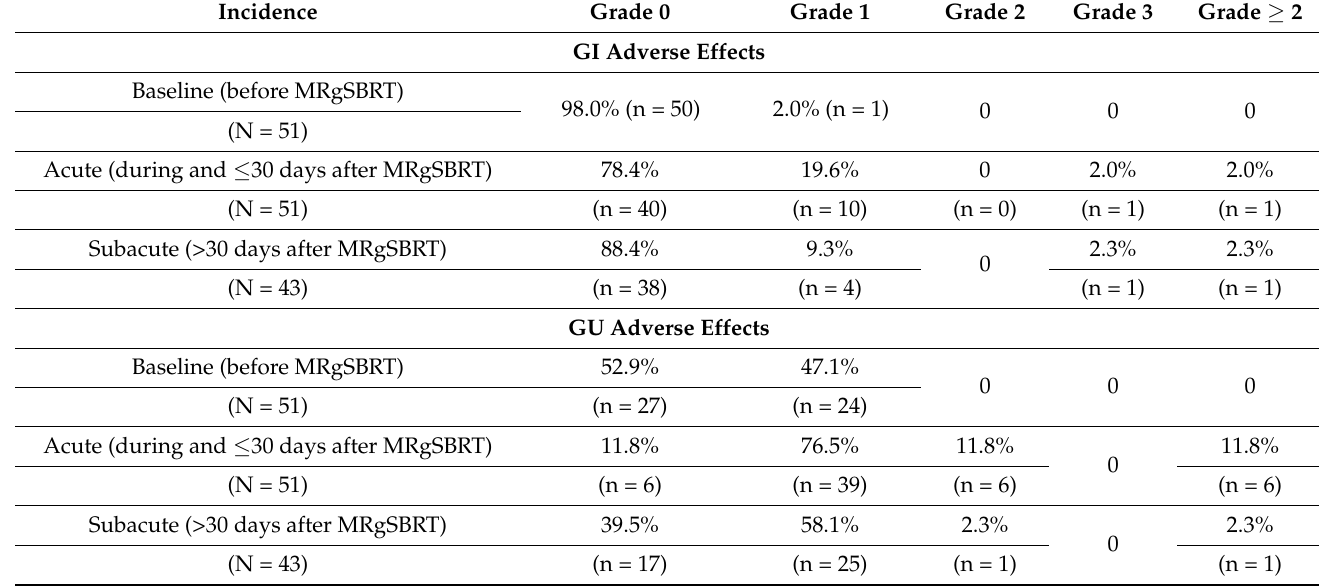
Table 2. Incidences of clinician-reported gastrointestinal (GI) and genitourinary (GU) adverse effects based on the Common Terminology Criteria for Adverse Events Scale (CTCAE) v. 5.0 in the patients. Incidence Grade 0 Grade 1 Grade 2 Grade 3 Grade ≥ 2 GI Adverse Effects Baseline (before MRgSBRT) 98.0% (n = 50) 2.0% (n = 1)